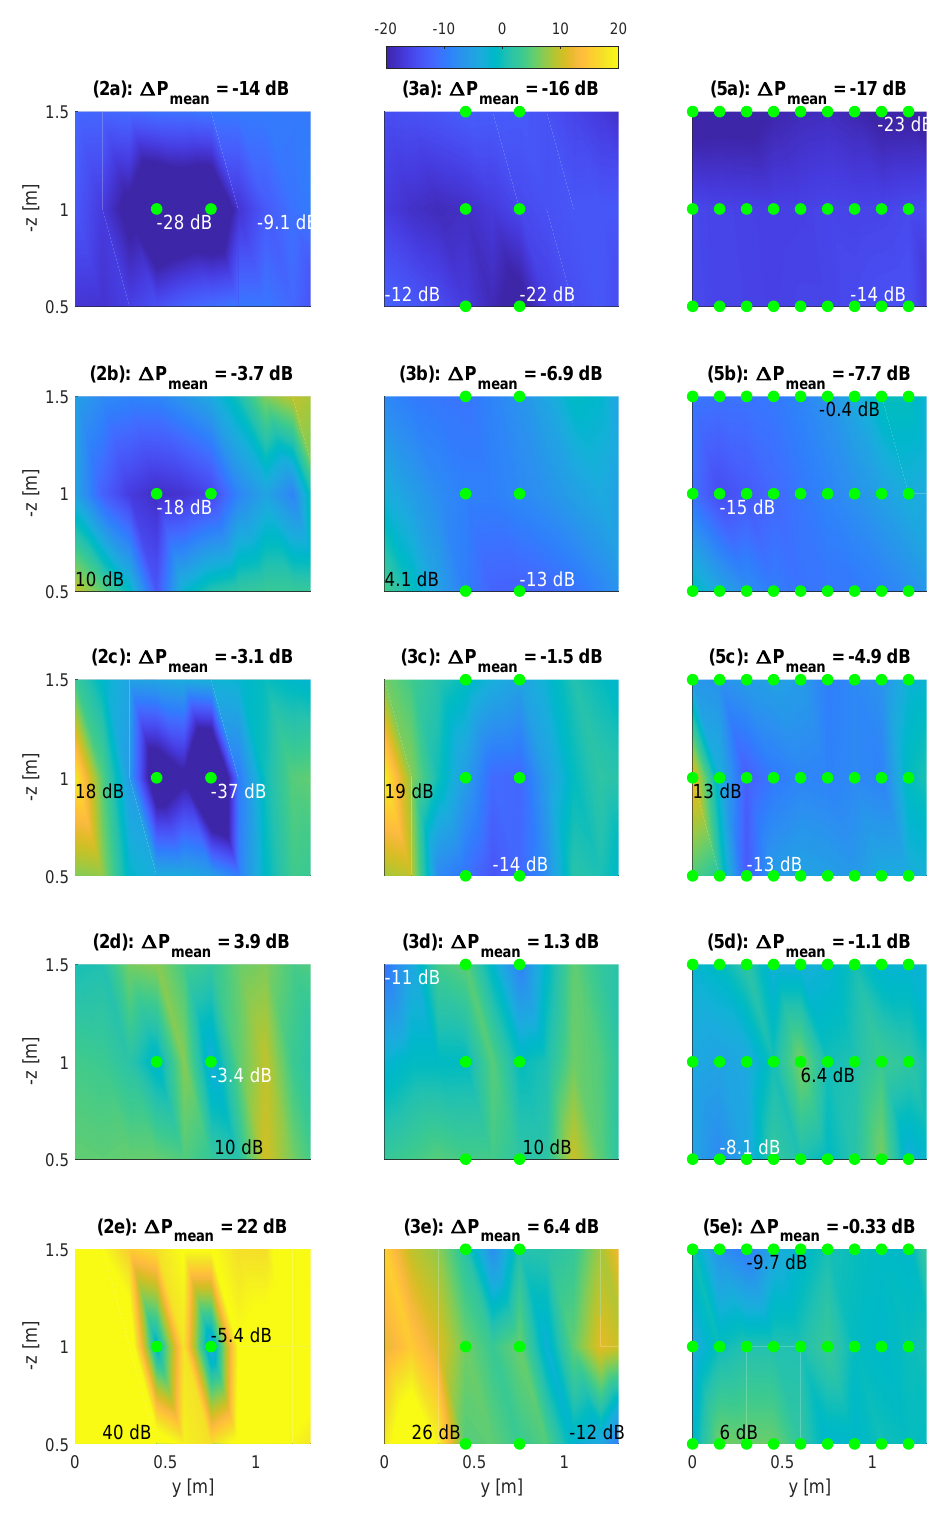
Figure 6. Tonal SPL reduction in front of the lining averaged over two planes. The row designation ( a ) to ( e ) refers to the five CROR frequencies. Three different virtual microphone configurations (2, 3 and 5) are evaluated relative to the uncontrolled case (1). The maximum, minimum and mean SPL reductions are provided for each plot. The locations of the virtual error microphones are indicated by a green